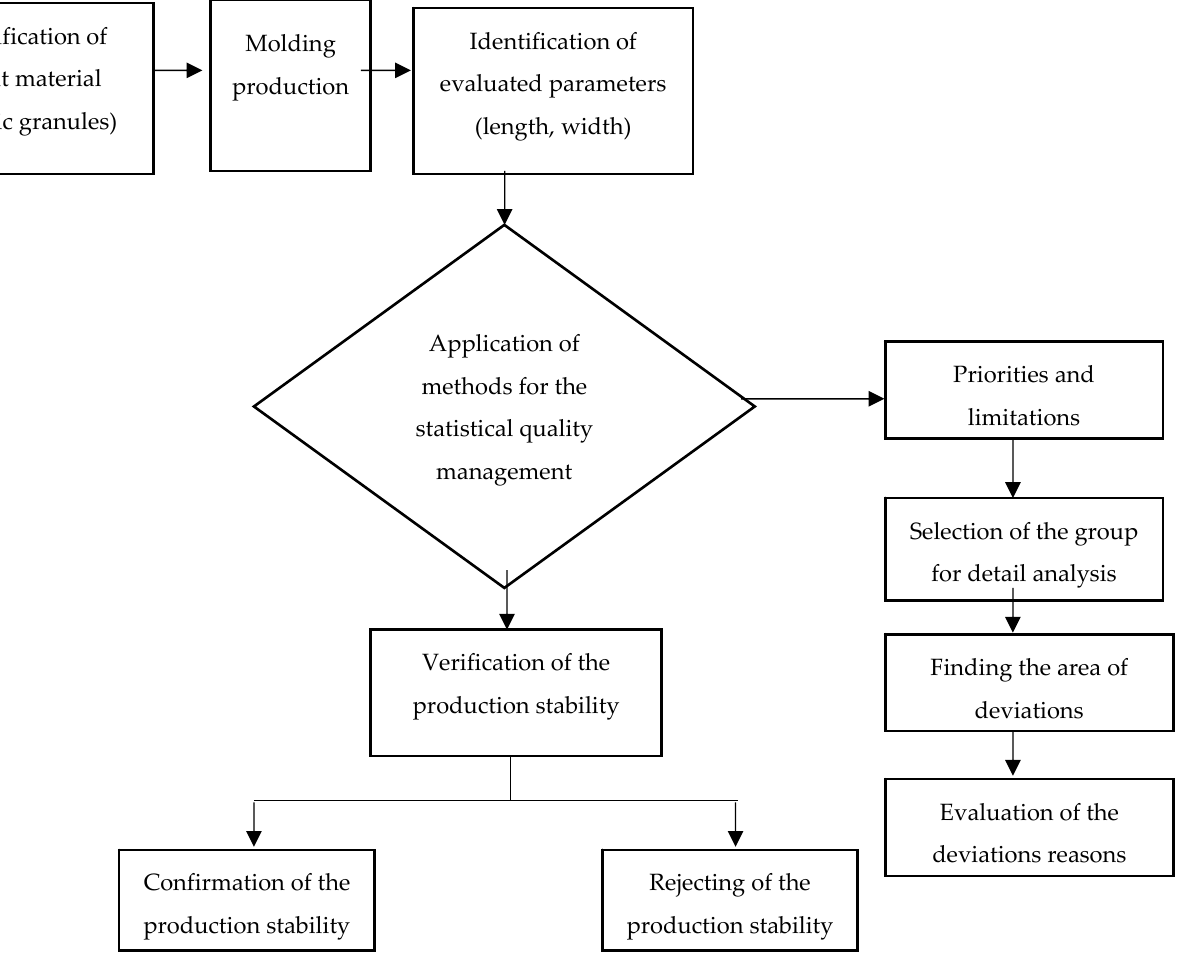
Figure 2. Methodical frame for the parameter identification of the production stability.